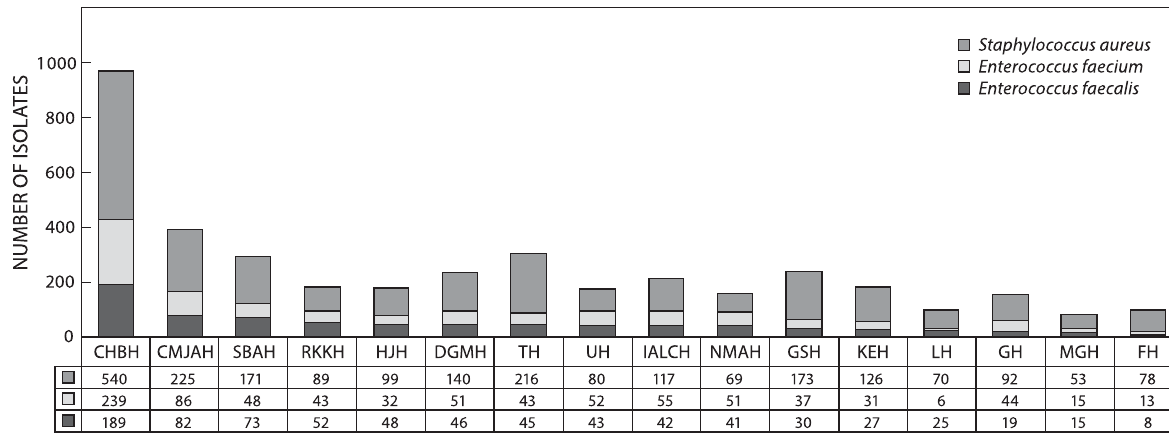
Table 9: Antimicrobial susceptibility patterns of Gram-positive bacteria isolated from blood cultures reported from 16 sentinel hospitals across South Africa, January 1, 2016 to December 31, 2016